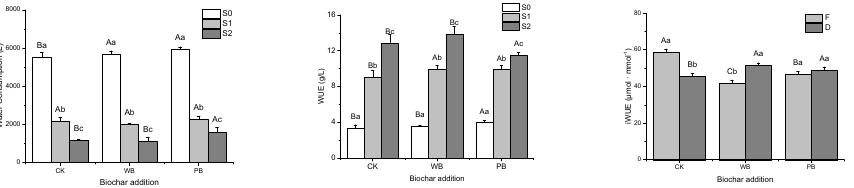
Figure 4. Water consumption, instantaneous water use efficiency (iWUE), and plant water use efficiency (WUE) as affected by biochar addition (B), drought stress (W), and salt stress (S). The treatments included biochar type (CK, WB, and PB), water supply (F and D), and salt conditions (S0, S1, and S2). Different uppercase letters indicate significant differences at the 0.05 level among CK, WB, and PB treatments. Different lowercase letters indicate significant differences at the 0.05 level within groups.